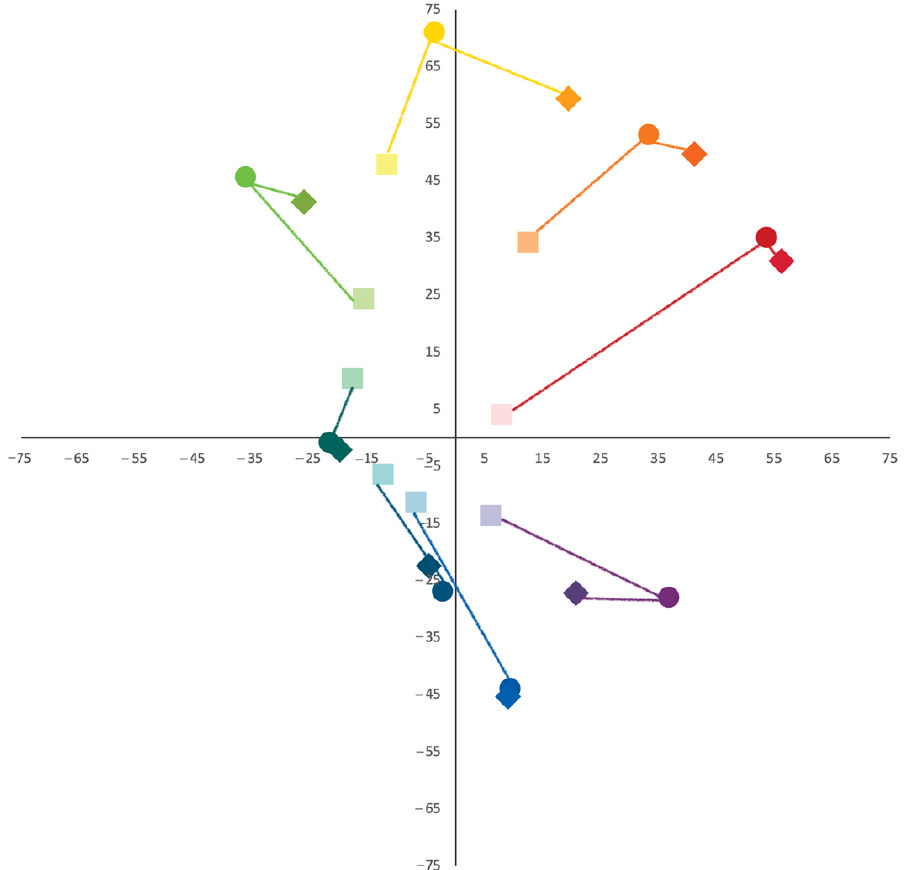
Figure 5. The main colors of the charts from Sections I (circle), II (square), and III (diamond) mapped in the a*b* plane of CIELAB color space; lines connect the different sections’ corresponding colors. The 10 color charts in Section IV include only five main colors (Table 1, Figure 6). All these colors represent different lightnesses (34.47 ≤ L ≤ 86.78) of red-brown shades with low chromaticity (8.93 ≤ C ≤ 36.92), three of which (charts 25, 27, and 28) almost completely coincide in hue (84.28 ≤ h ◦ ≤ 85.39), while two others (charts 26 and 30) fall within the color circle’s 30-degree arc between red and yellow (44.73 ≤ h ◦ ≤